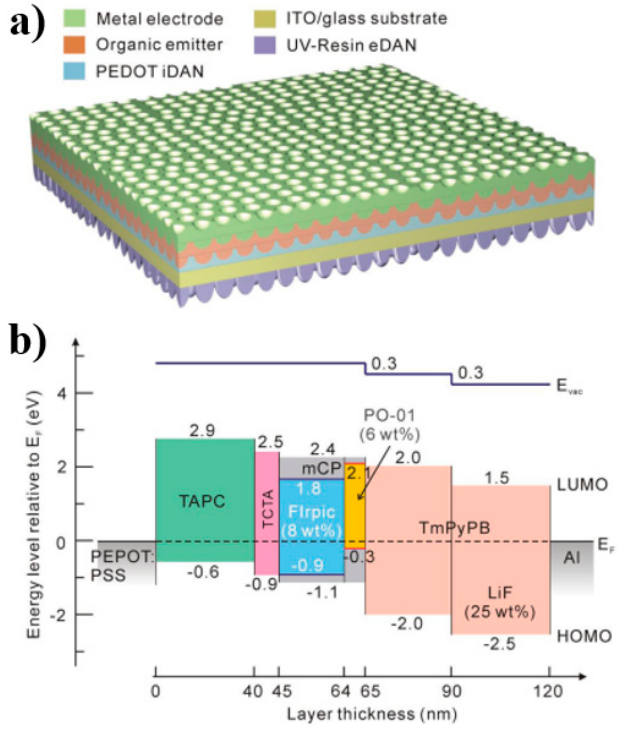
Figure 14. ( a ) Schematic of the WOLED; ( b ) Energy level diagram of the organic emitter with the alignment of the Fermi level across the interface. Reproduced from Reference [9].